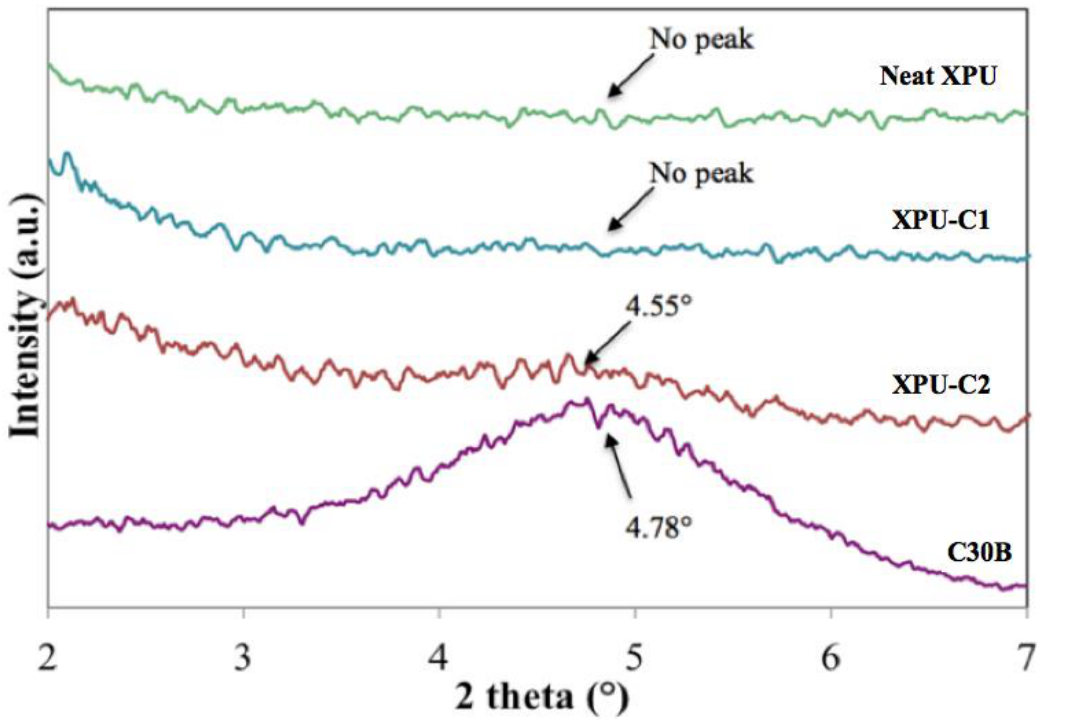
Figure 3. Diffractograms of Cloisite 30B and nanocomposites at varying clay concentrations.